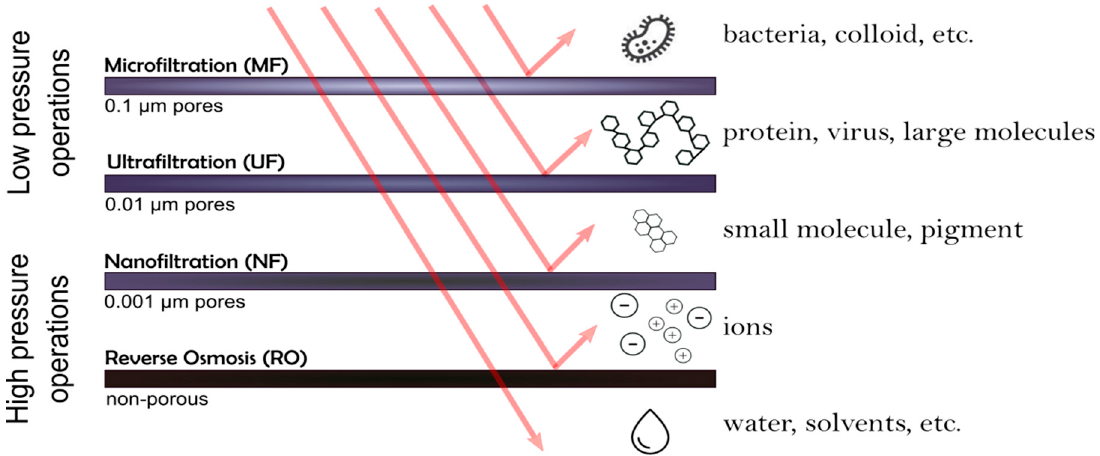
Figure 1. Schematic representation of membranes-based separation